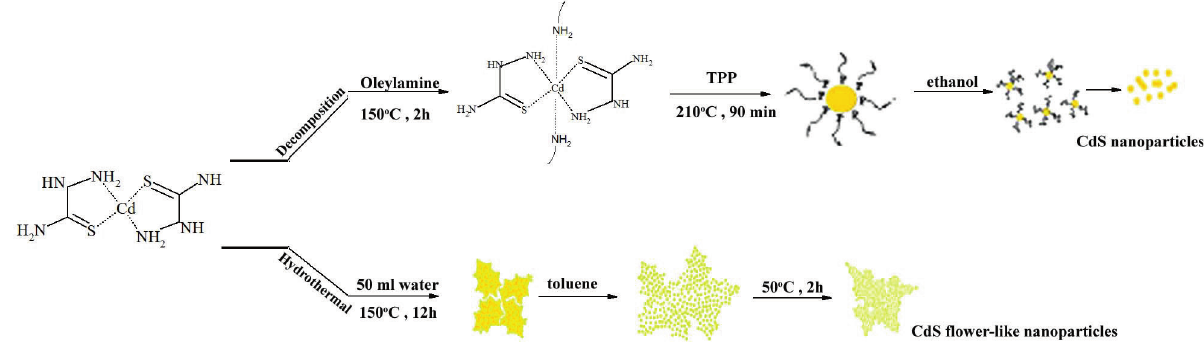
Scheme 1. Proposed mechanism for preparation of CdS nanoparticles by two